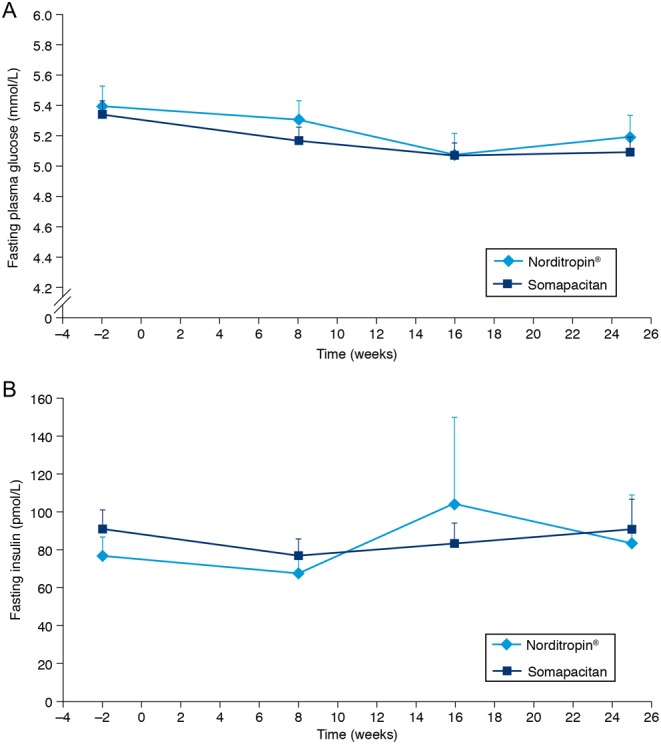
(A) Fasting plasma glucose values and (B) fasting plasma insulin vs time. Values are mean + s.e.m.